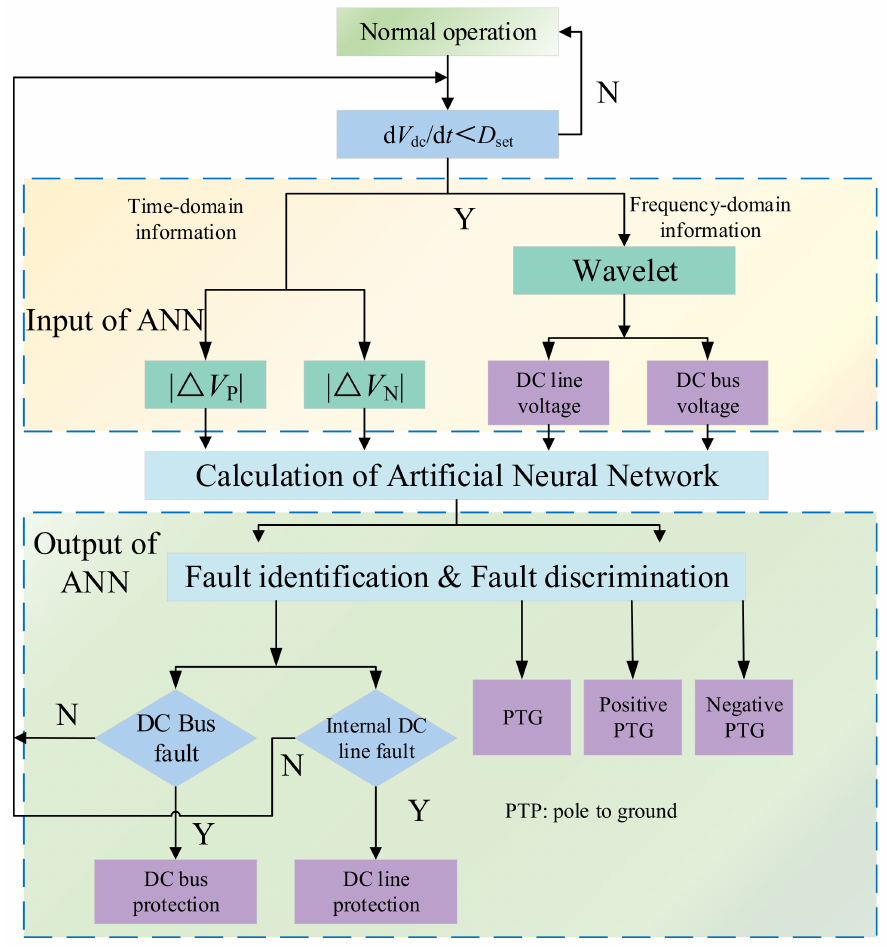
Figure 3. Flow chart of fault